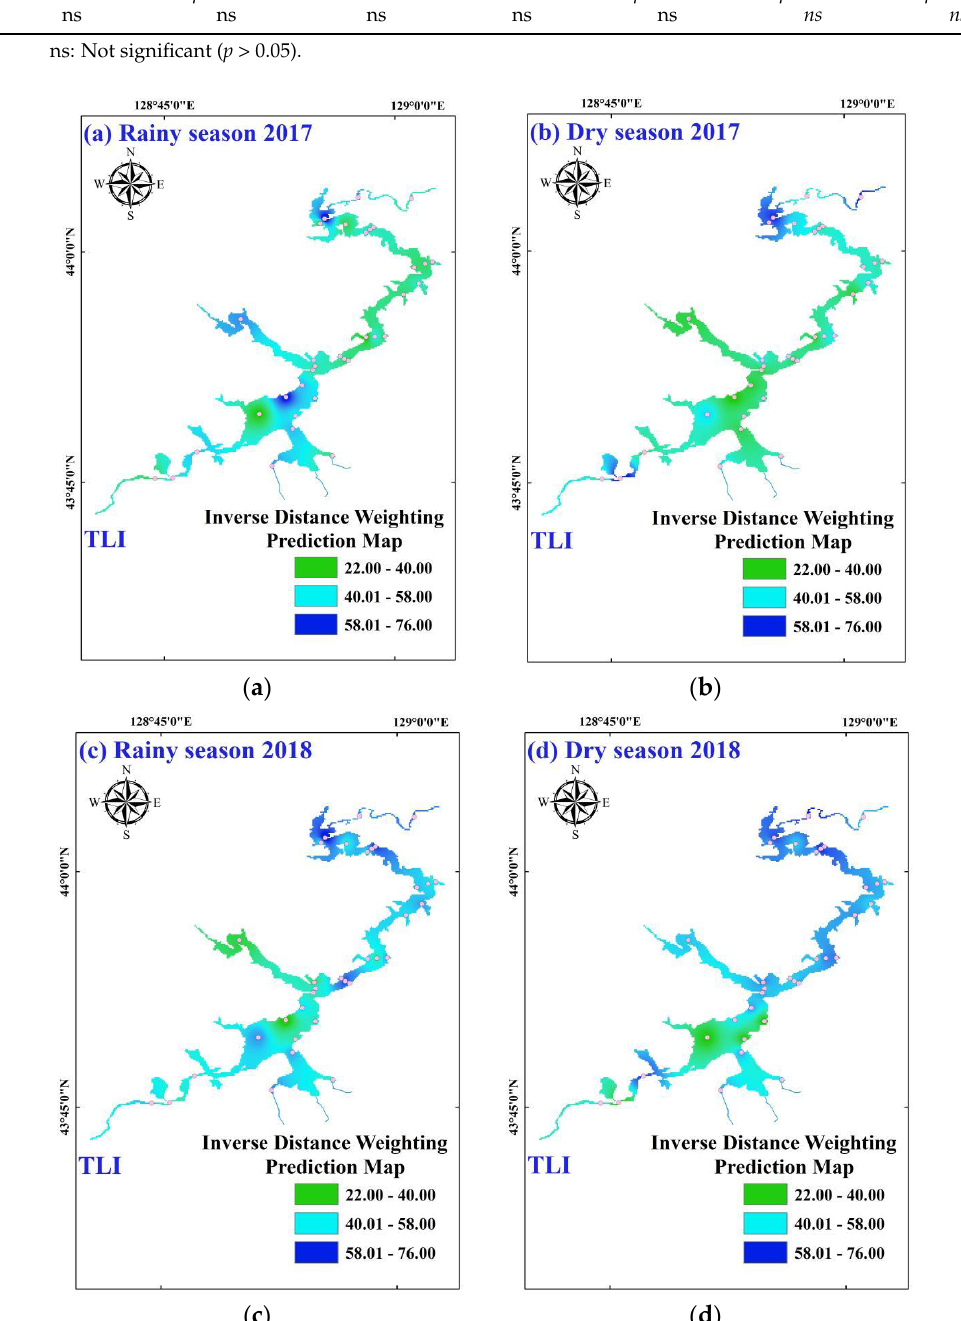
Figure 2. The spatial distribution of TLI in the study period. ( a ) Rainy season (August 2017); ( b ) dry season (October 2017); ( c ) rainy season (August 2018); ( d ) dry season (October 2018). The interpolation map was constructed by ArcGIS software using the Inverse Distance Weighting method.